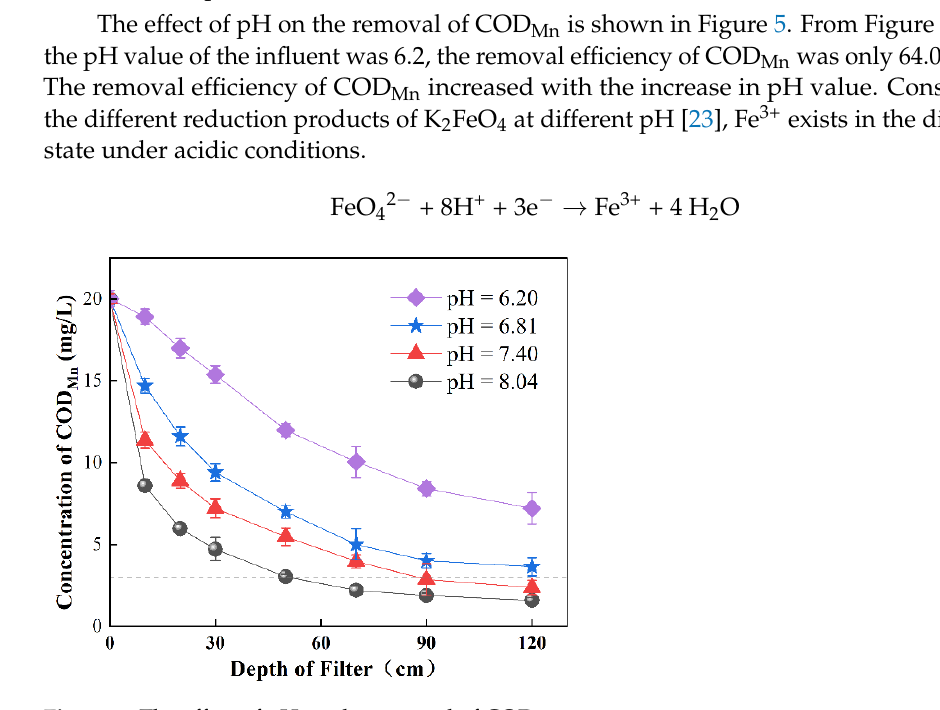
Figure 5. The effect of pH on the removal of COD